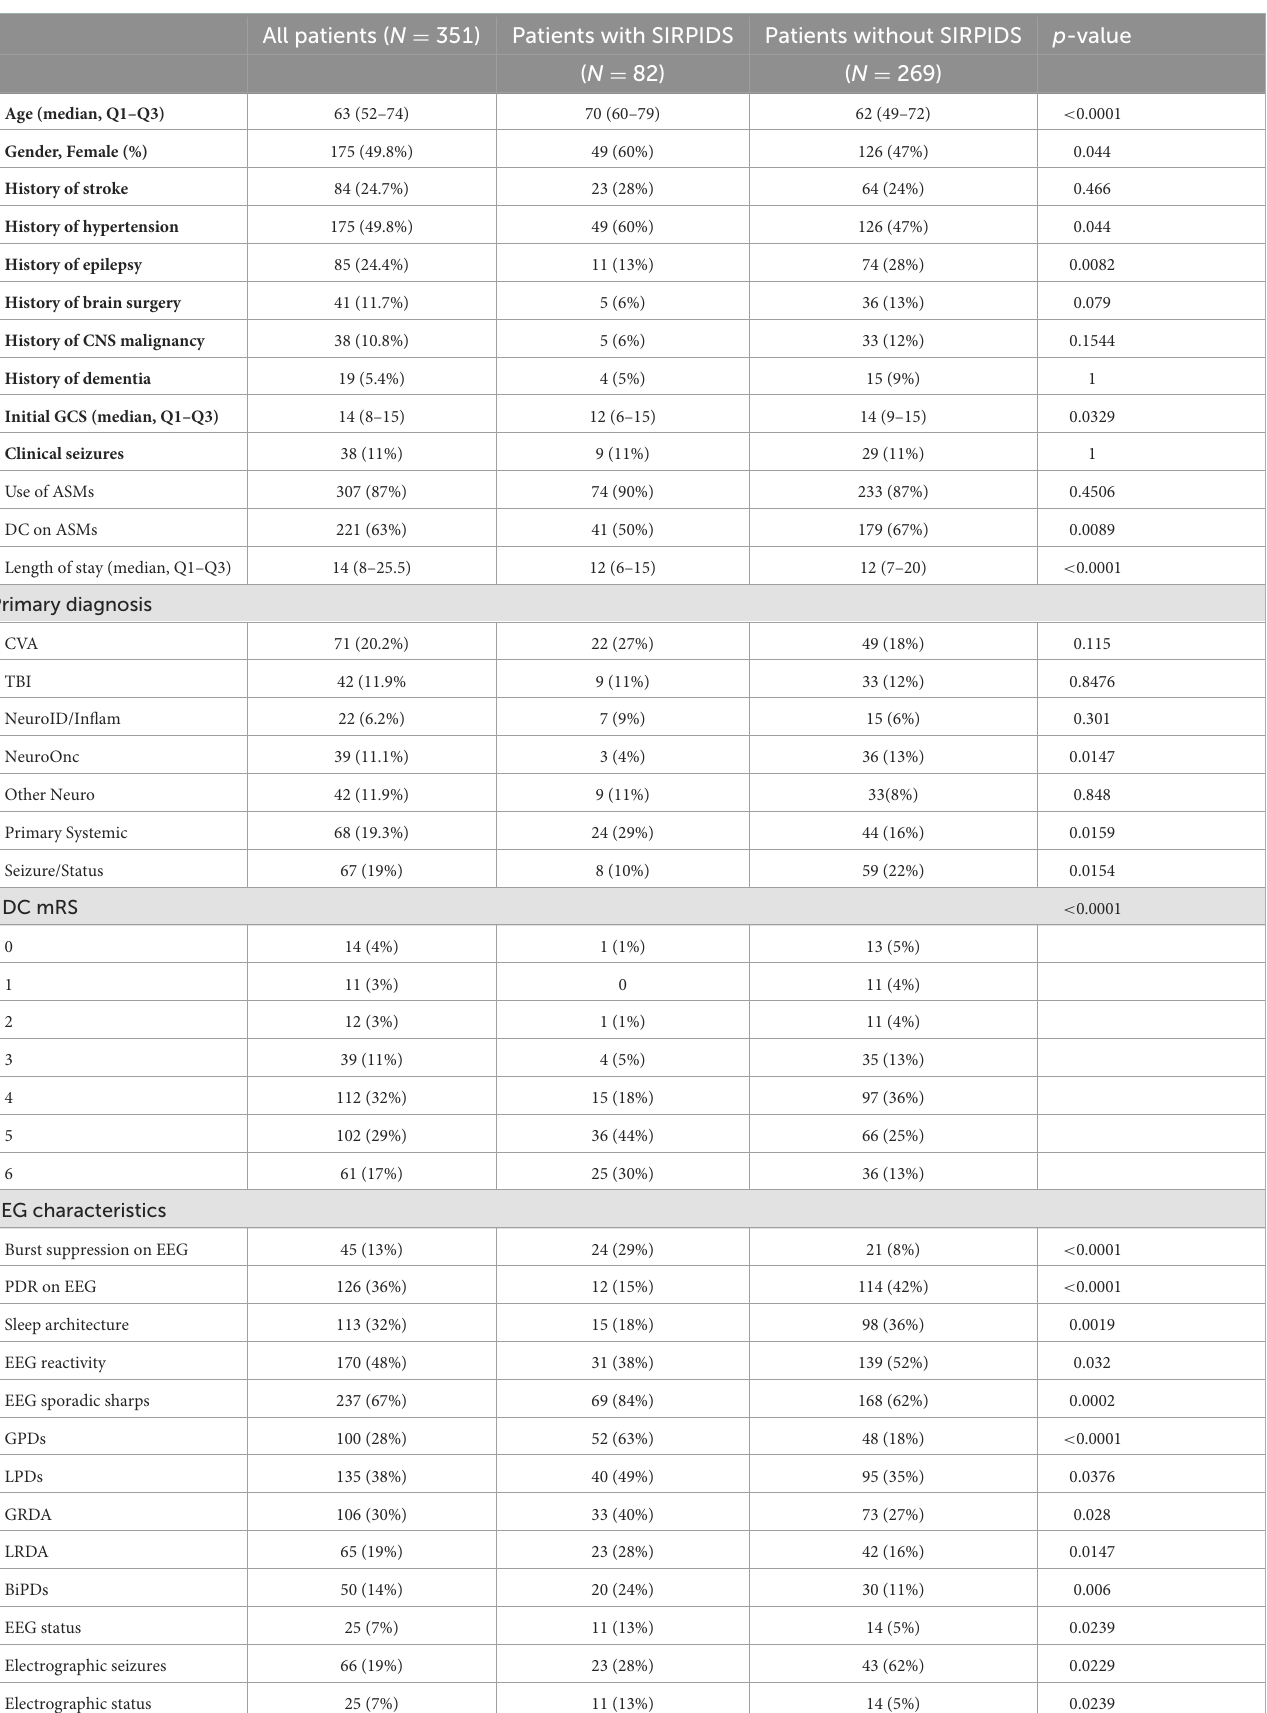
TABLE 1 Baseline characteristics and outcomes. All patients ( N =